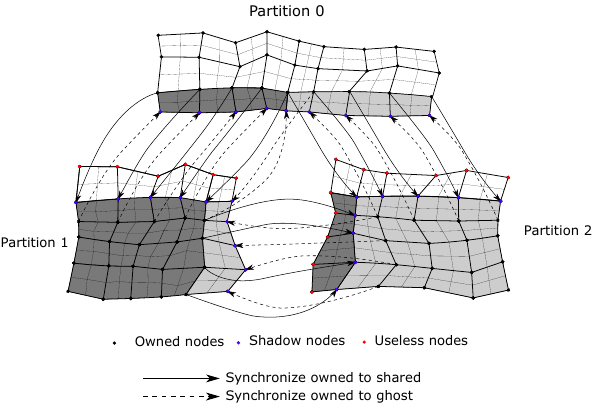
Figure 7. Communication process among